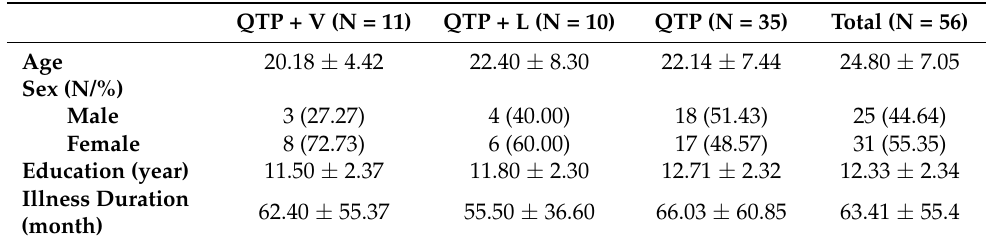
Table 2. Total scores of HAMA, YMRS, MARDS, CUDOS of three groups at enrolment, two weeks